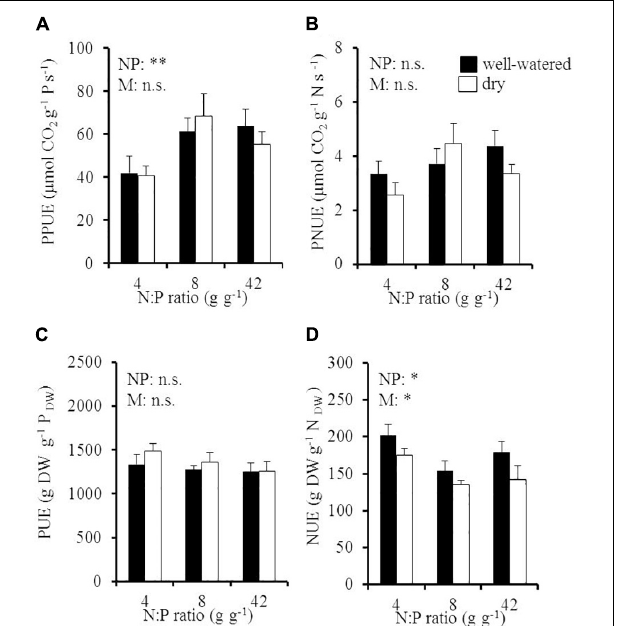
FIGURE 4 | (A) Instantaneous late-summer photosynthetic P use efficiency (PPUE), (B) instantaneous late-summer photosynthetic N use efficiency (PNUE), (C) P use efficiency (PUE), and (D) N use efficiency (NUE) of young Palestine oak ( Quercus calliprinos ) trees grown at increasing soil N:P ratio and decreasing soil moisture in a climate chamber. Shown are means and standard errors for replicate saplings ( n = 48 for PPUE and PUE; n = 24 for PNUE and NUE). The results of two-way ANOVAs on the significance of the effect of the soil N:P ratio (NP) or soil moisture (M) are indicated by asterisks ( ∗∗ and ∗ for p ≤ 0.01 and 0.05; n.s., not